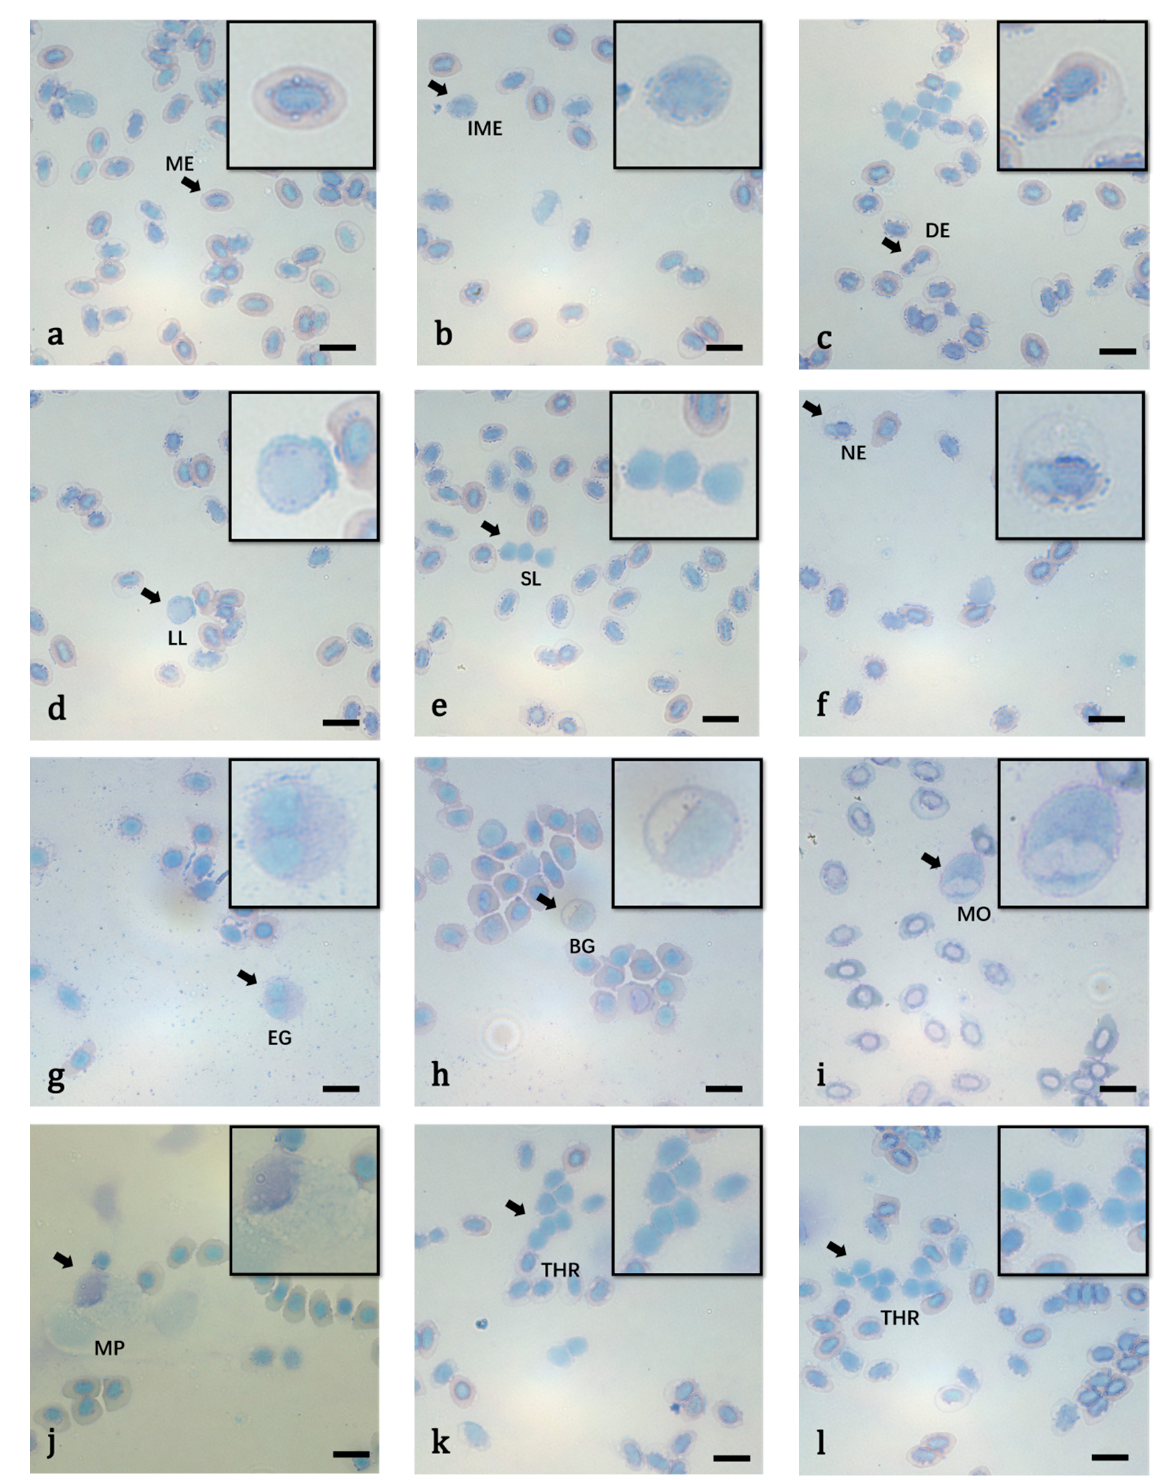
Figure 2. The microstructure of peripheral blood cells of zebrafish (Wright ‐ Giemsa staining). ( a ) Mature erythrocyte (ME) (arrow); ( b ) immature erythrocyte (IME) (arrow); ( c ) dividing erythrocyte (DE) (arrow); ( d ) large lymphocyte (LL) (arrow); ( e ) small lymphocyte (SL) (arrow); ( f ) neutrophil (NE) (arrow); ( g ) eosinophils (EG) (arrow); ( h ) basophilic granulocyte (BG) (arrow); ( i ) monocyte (MO) (arrow); ( j ) macrophage (MP) (arrow); ( k , l ) thrombocytes in clusters (TH) (arrow). Bars = 10 μ m. Erythrocytes were the predominant cell type found in the blood. Mature and imma ‐ ture erythrocytes were observed in the peripheral blood but most were mature erythro ‐ cytes. The mature erythrocytes were oval, with a smooth surface. The cytoplasm was full of hemoglobin and was orange or light purplish ‐ red in color. The nuclei were oval in shape, small and located in the middle of the cell. The nuclear chromatin was dense,